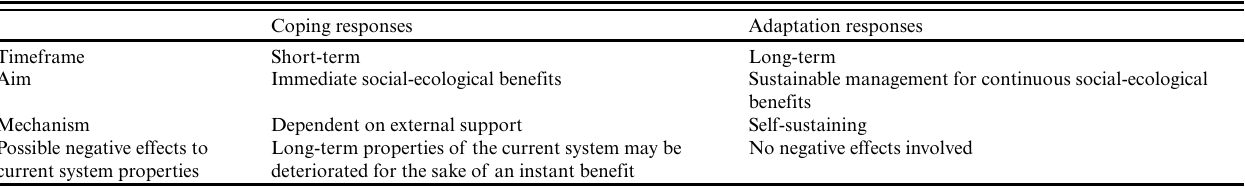
Table 1. Distinction of coping responses and adaptation responses, adapted from Berkes and Jolly (2001), Fabricius et al. (2007), and Tuvendal and Elmqvist